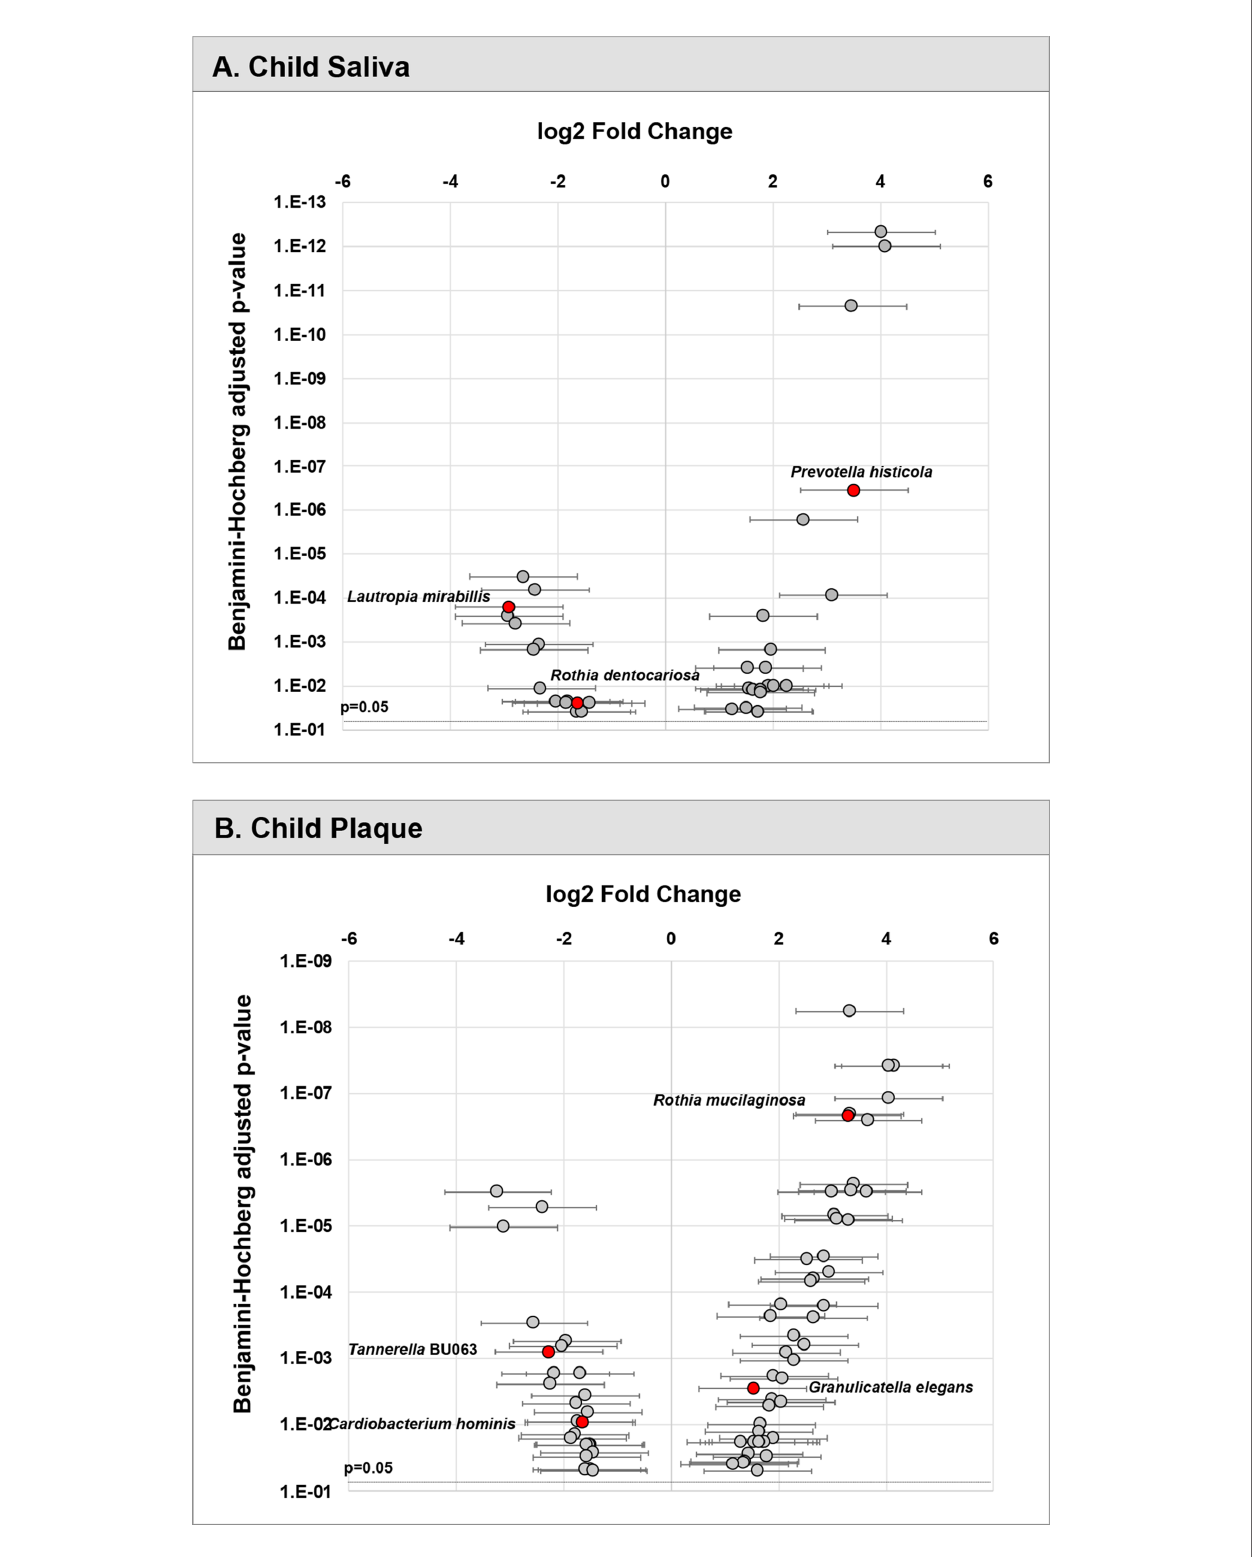
FIGURE 3 | Differential abundance of taxa in children ’ s saliva and plaque. Relative fold change in abundance of species in saliva (A) and plaque (B) from children with ECC vs. caries-free. All species plotted with a p value <0.05.